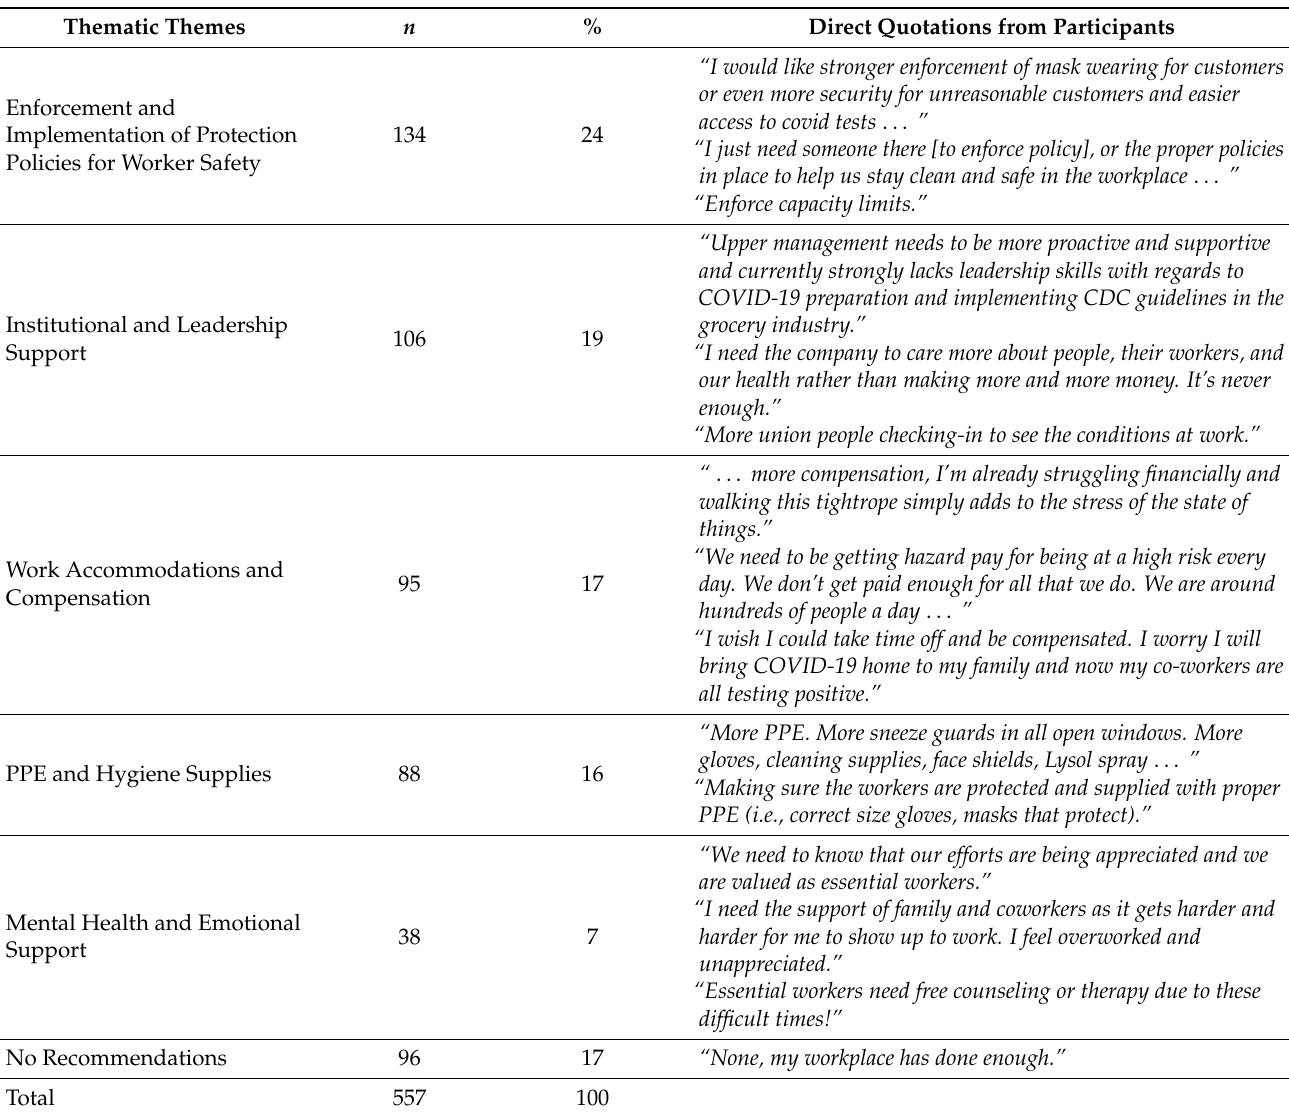
Table A1. Thematic coding of suggestions made by GSWs to improve their ability to work ( n =